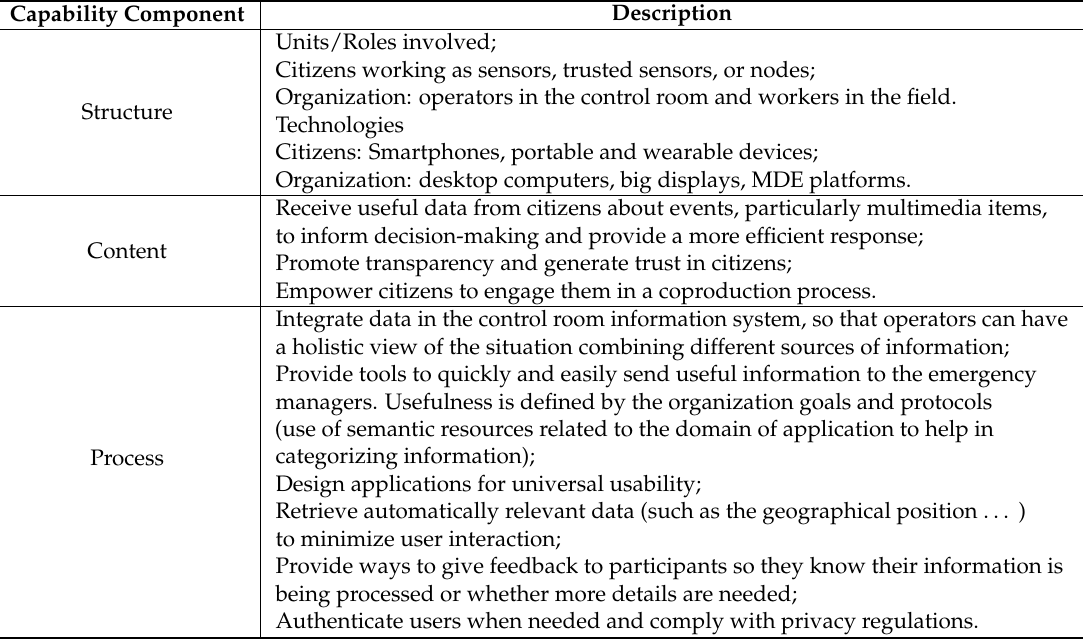
Table 2. Scenario 1: Citizens as sensors, trusted sensors, and